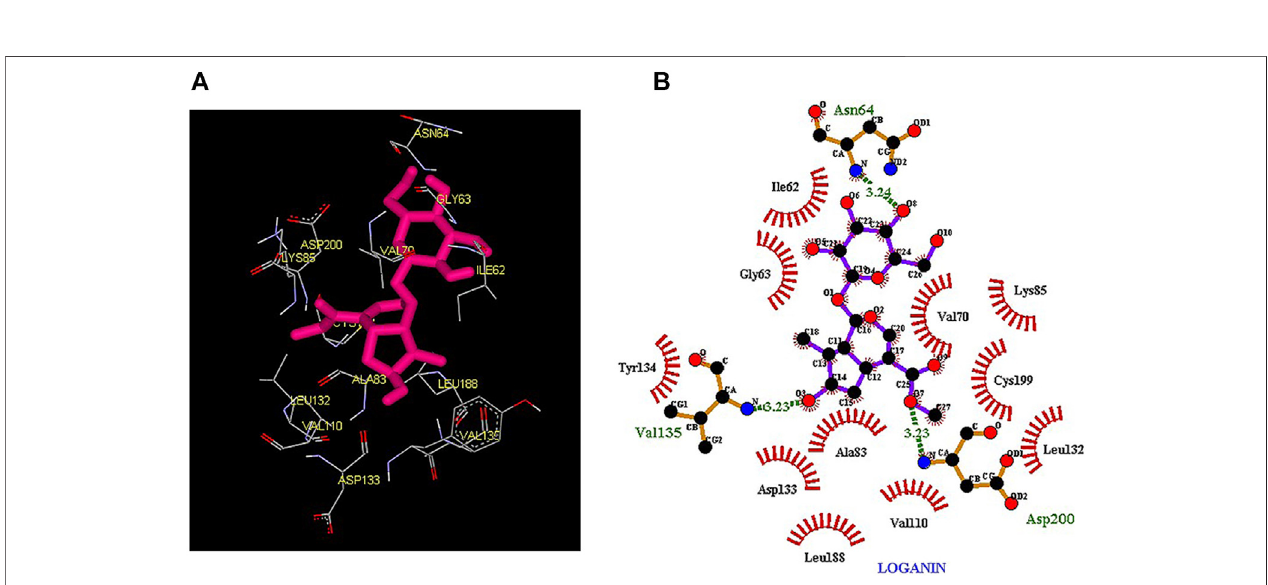
FIGURE 2 | (A) Three-dimensional view of loganin at the GSK_3 β protein binding site. (B) Interactions of loganin with amino acids of the GSK3_ β protein binding site.